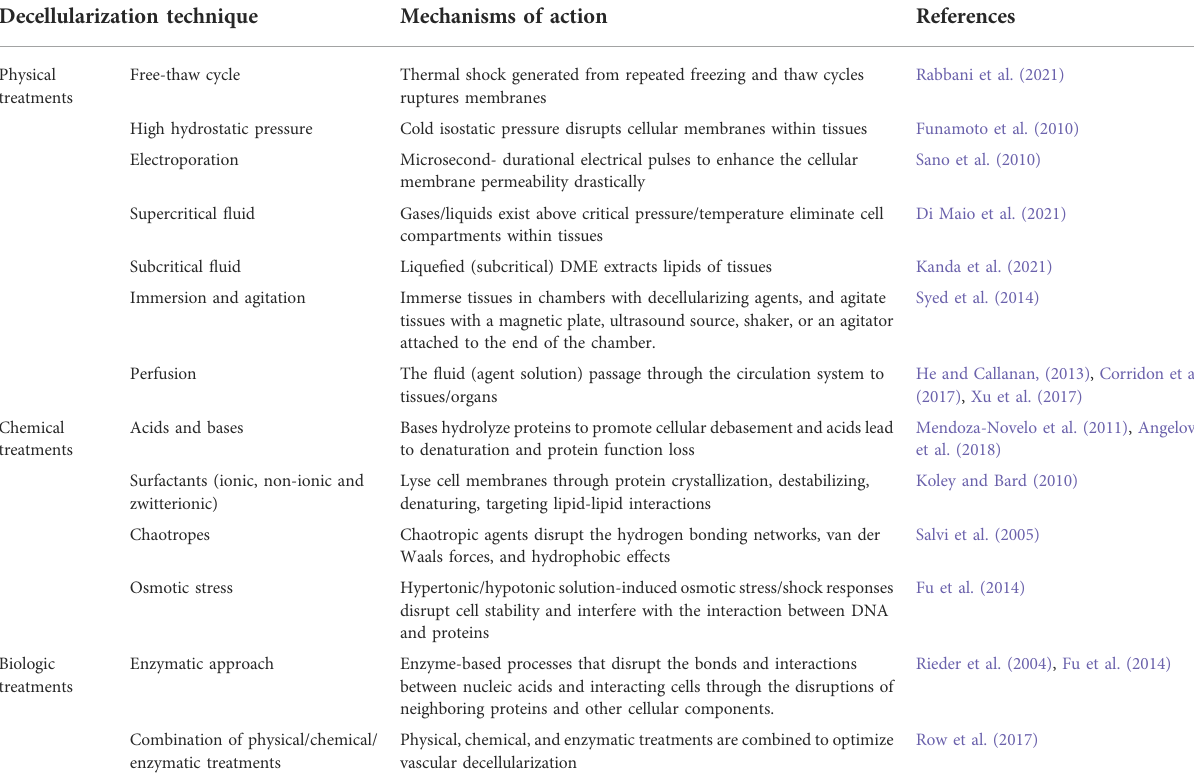
TABLE 1 A systematic summary of decellularization methods, their mechanisms of actions, and related